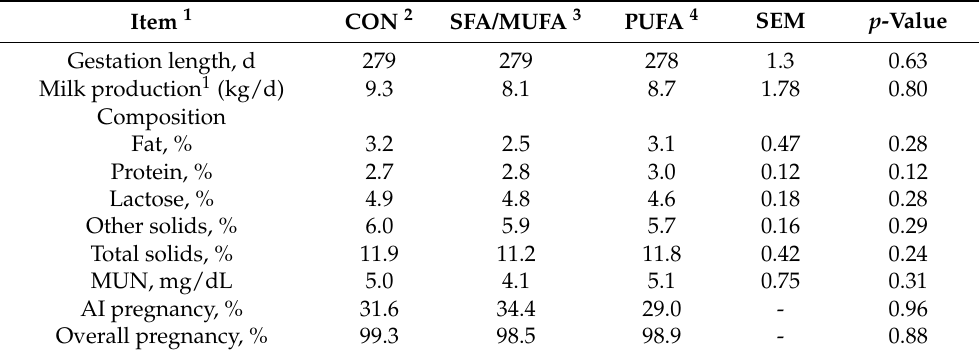
Table 7. Effects of supplementation for the last 82 ± 5 d of gestation of soybean hulls mixed with either whole-shelled corn (CON), Ca salts of saturated/monounsaturated fatty acids (SFA/MUFA), or Ca salts of polyunsaturated fatty acids (PUFA) on milk production and cow reproductive